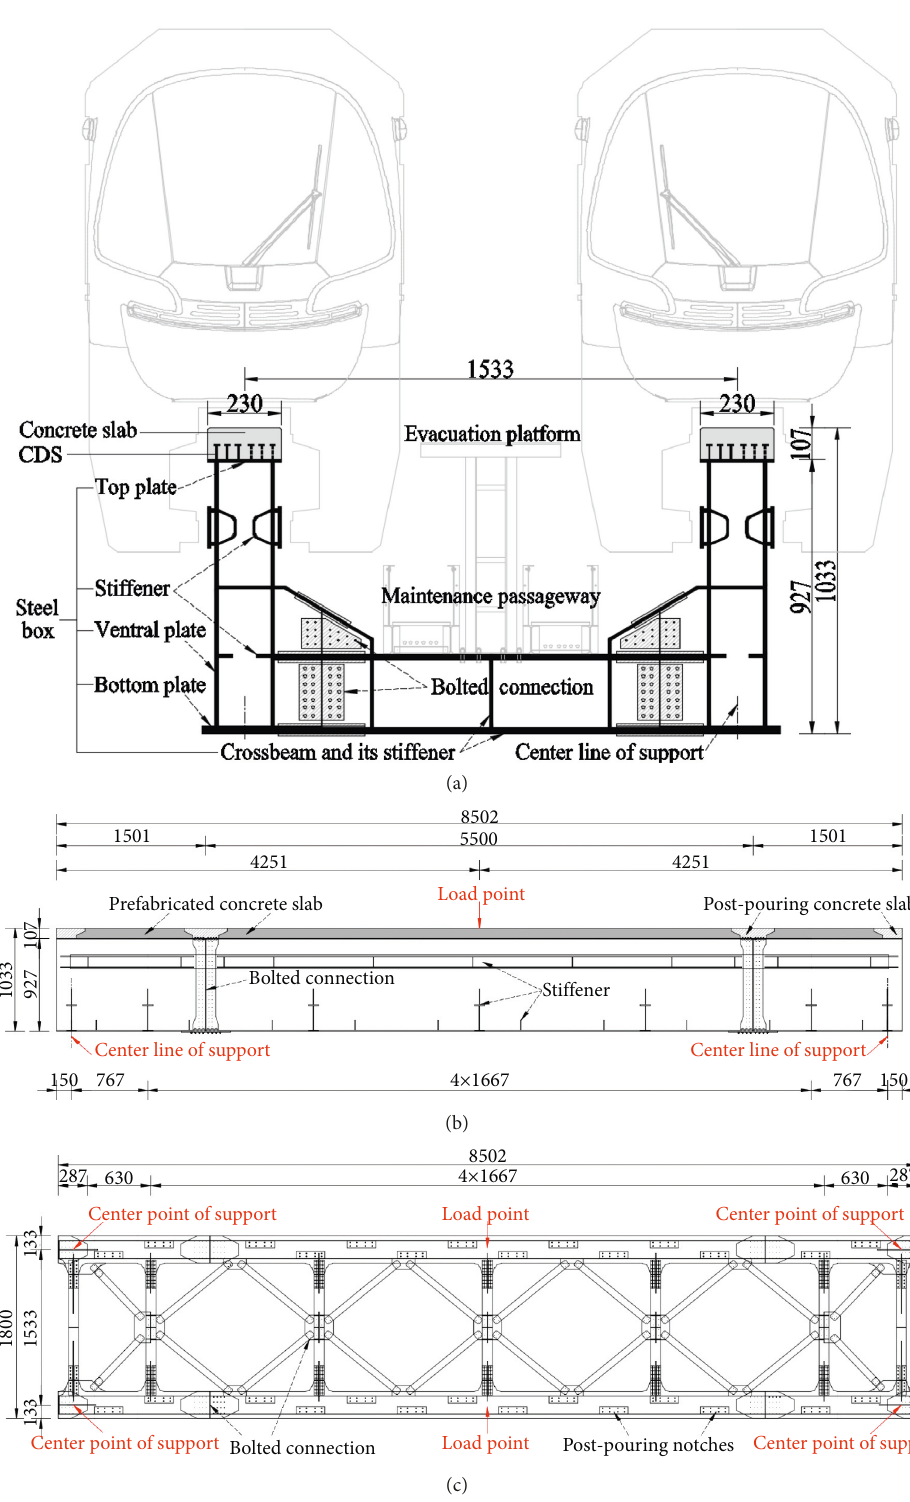
Figure 3: Scale model of test beam of straddle monorail with a scale ratio of 1:3 (unit: mm). (a) Side view. (b) Front view. (c) Top